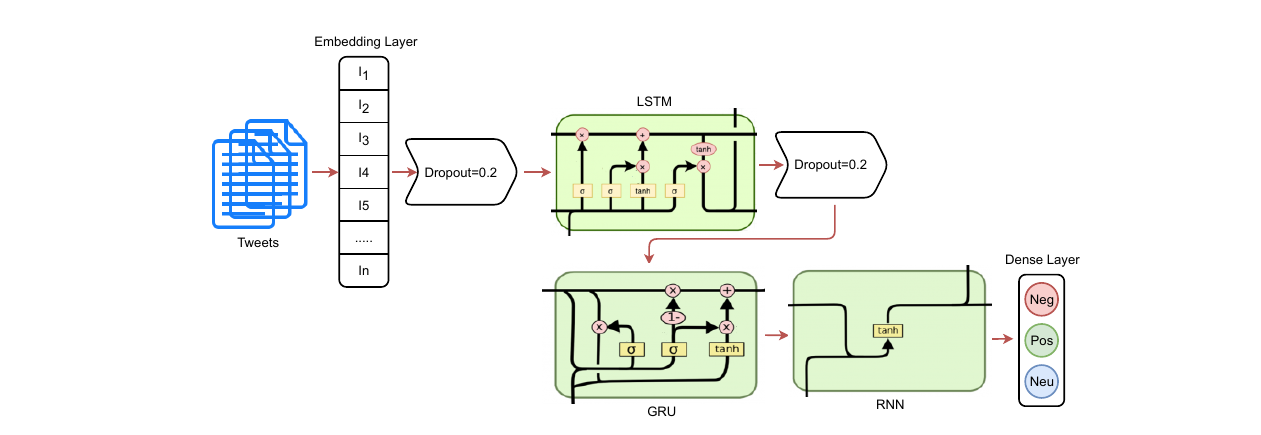
Figure 2. Flow diagram of proposed LSTM-GRNN